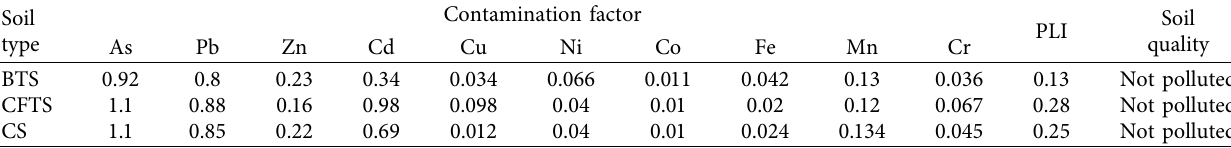
Table 8: Contamination factor (CF) and pollution load index (PLI) of heavy